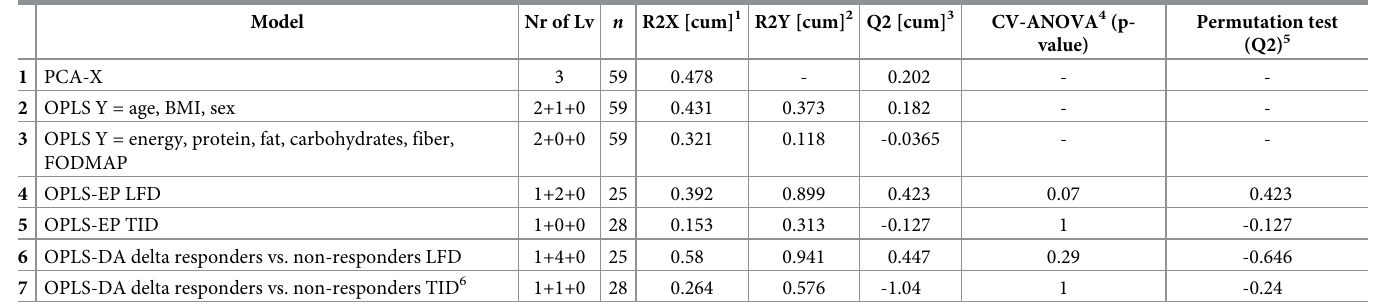
Table 3. Multivariate models in urine from participants receiving a low FODMAP diet and traditional IBS diet.